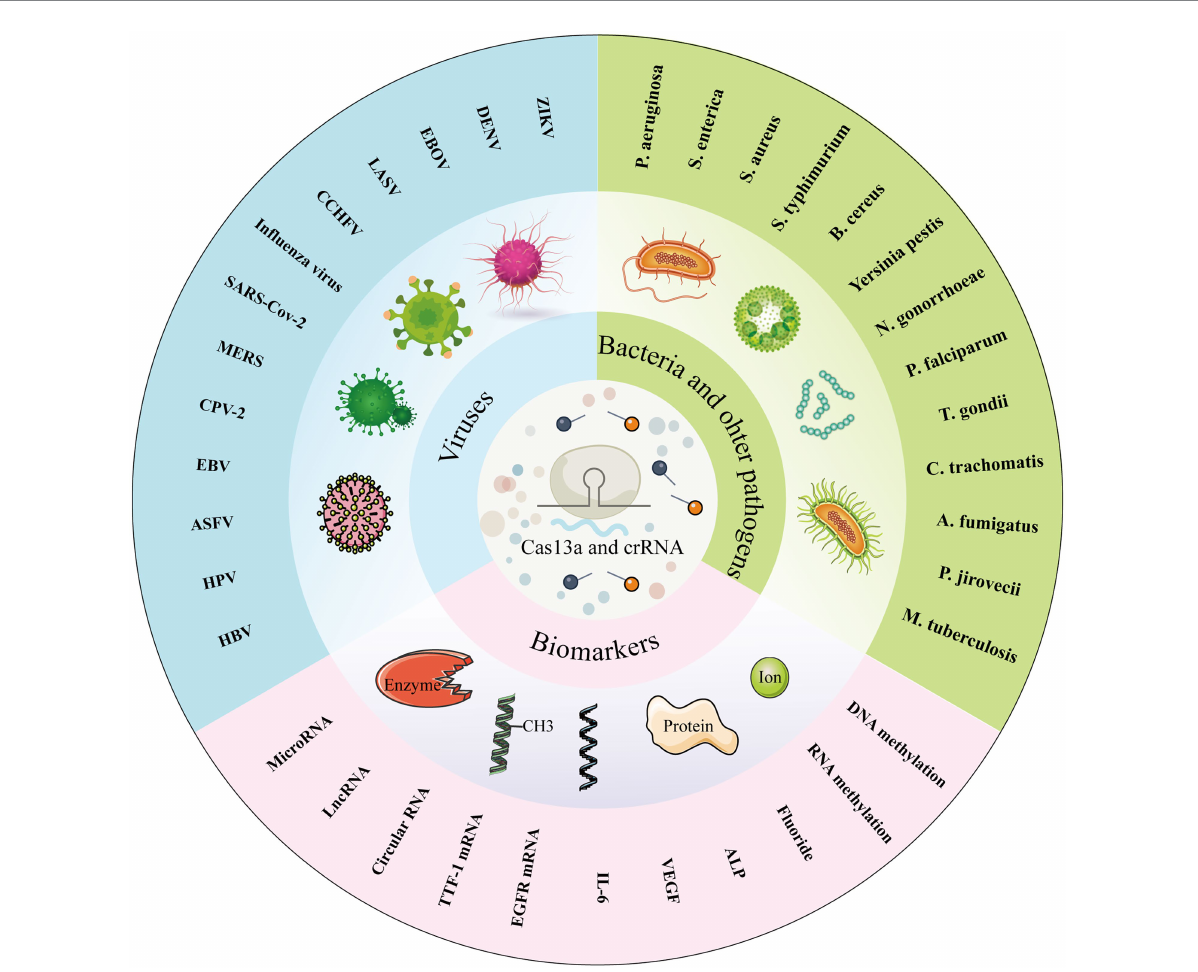
FIGURE 2 Various targets detected by Cas13a-based biosensors. Cas13a-based biosensors are able to detect pathogens, including viruses, bacteria, parasites, chlamydia, and fungus; biomarkers, such as microRNAs, IncRNAs, and circRNAs; and some non-nucleic acid targets, including proteins, ions, and methyl